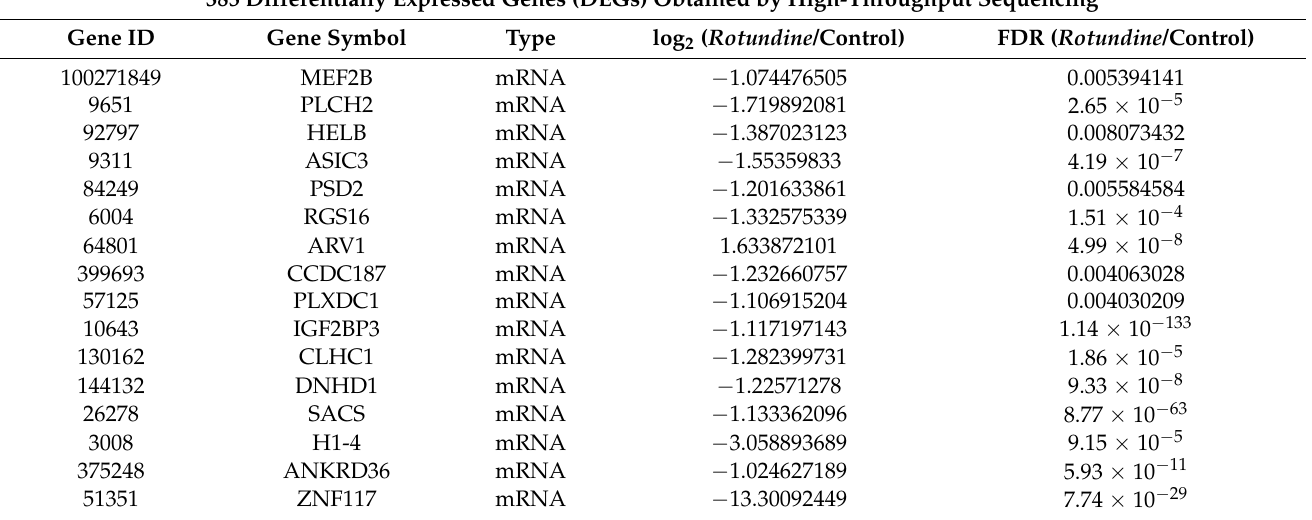
Table 1. The 385 differentially expressed genes (DEGs) obtained by high-throughput sequencing. 385 Differentially Expressed Genes (DEGs) Obtained by High-Throughput